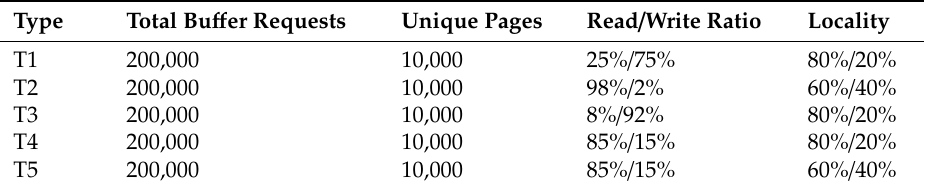
Table 2. Details of the five synthetic traces.